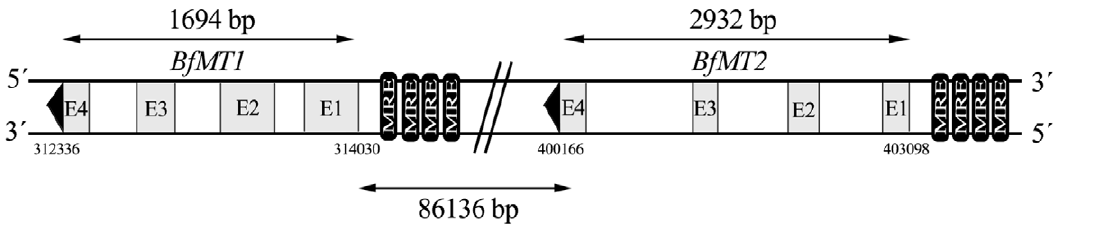
Figure 2. The genomic localization, orientation and structure of the BfMT1 and BfMT2 genes coincide in a 100-Kb region of the B. floridae genome. Both are located in the negative strand of the B. floridae genome scaffold 398. Exact location in pair bases with respect to the scaffold sequence is represented below each gene. The distance between both genes, as well as their size, are also indicated. Exons are shown in gray, and numbered E1 to E4. Black arrows indicate the transcription direction and the metal response elements (MREs) identified in the promoter regions are represented as black boxes.